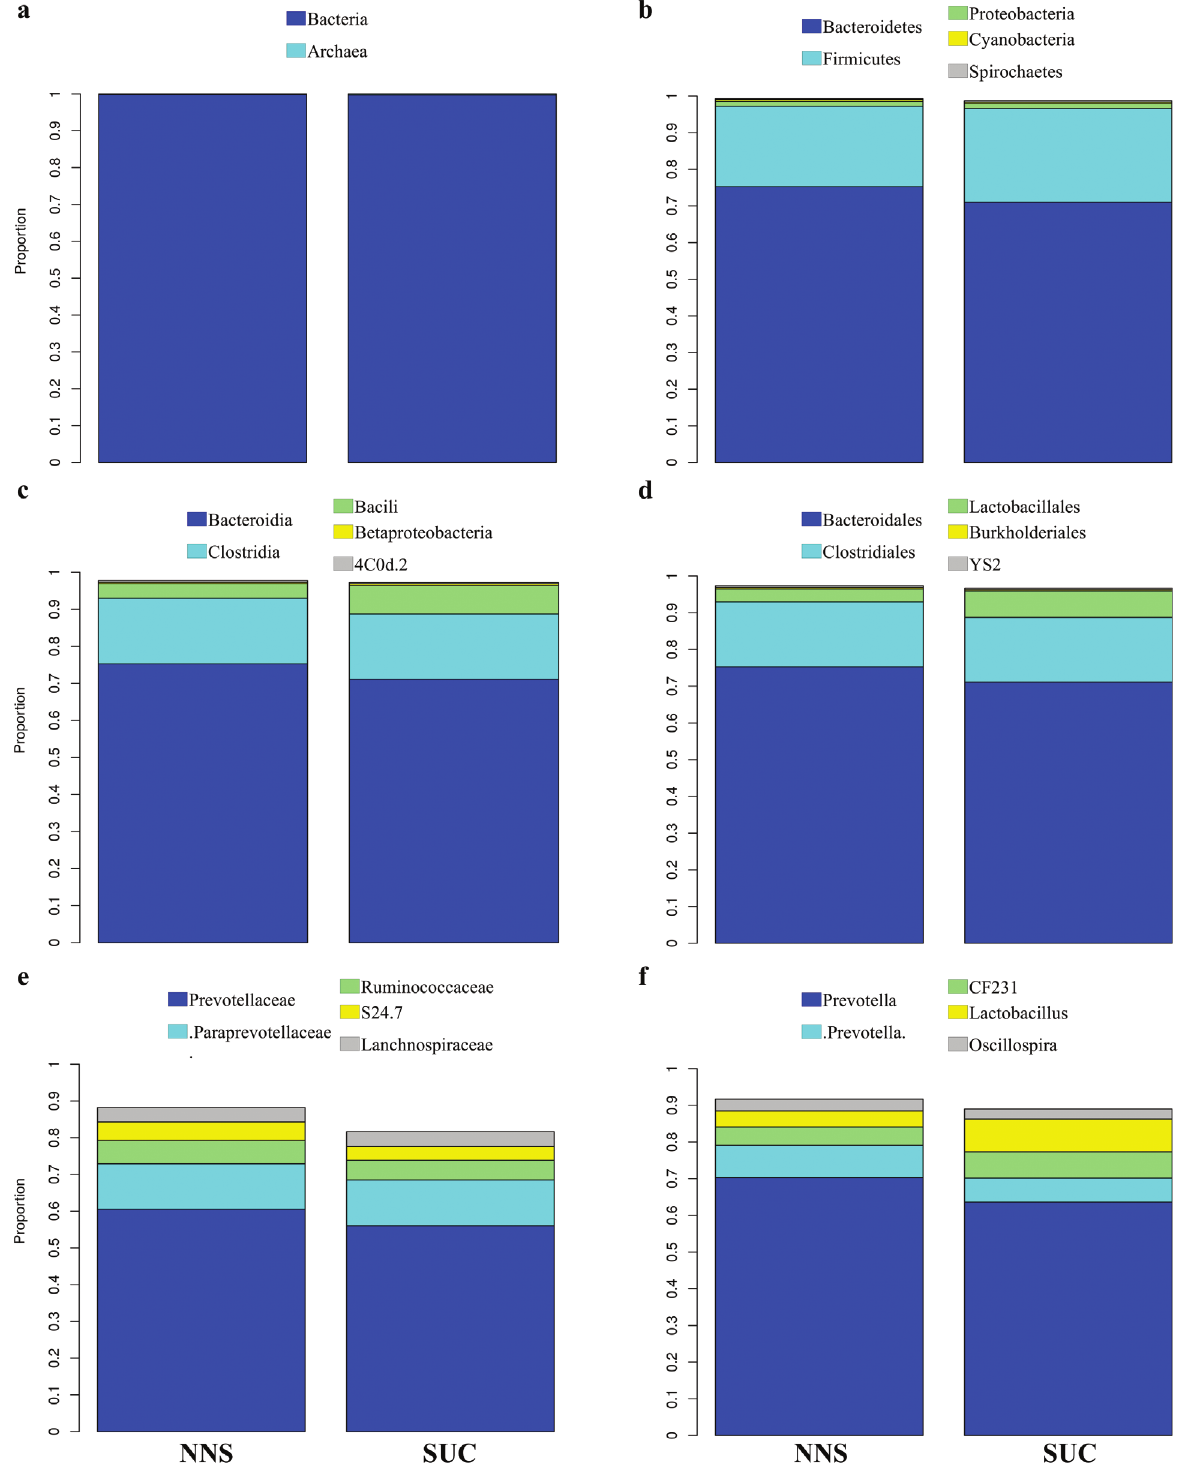
Figure 2 - Average proportion of the two represented (a) domains and the five most representative (b) phyla, (c) classes, (d) orders, (e) families, and (f) genera among the experimental groups. Color key at the top of each figure. NNS, non-nutritive sweetener (n = 10); SUC, sucrose (n =